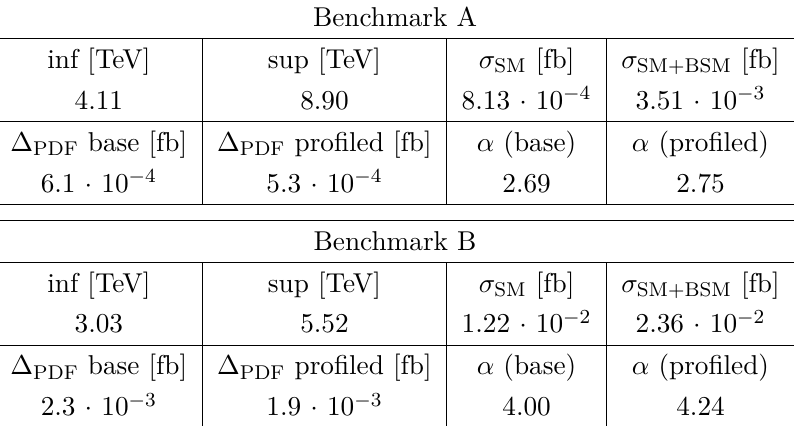
Table 4 . Integration limits for the peak region, integrated cross section for the SM background and the complete model and its PDF uncertainty with the baseline CT18NNLO PDF set [37] and the profiled PDF set using A FB + A W pseudodata as well as the significances α employing the two PDF errors for an integrated luminosity of 3000 fb − 1 for the benchmarks A and